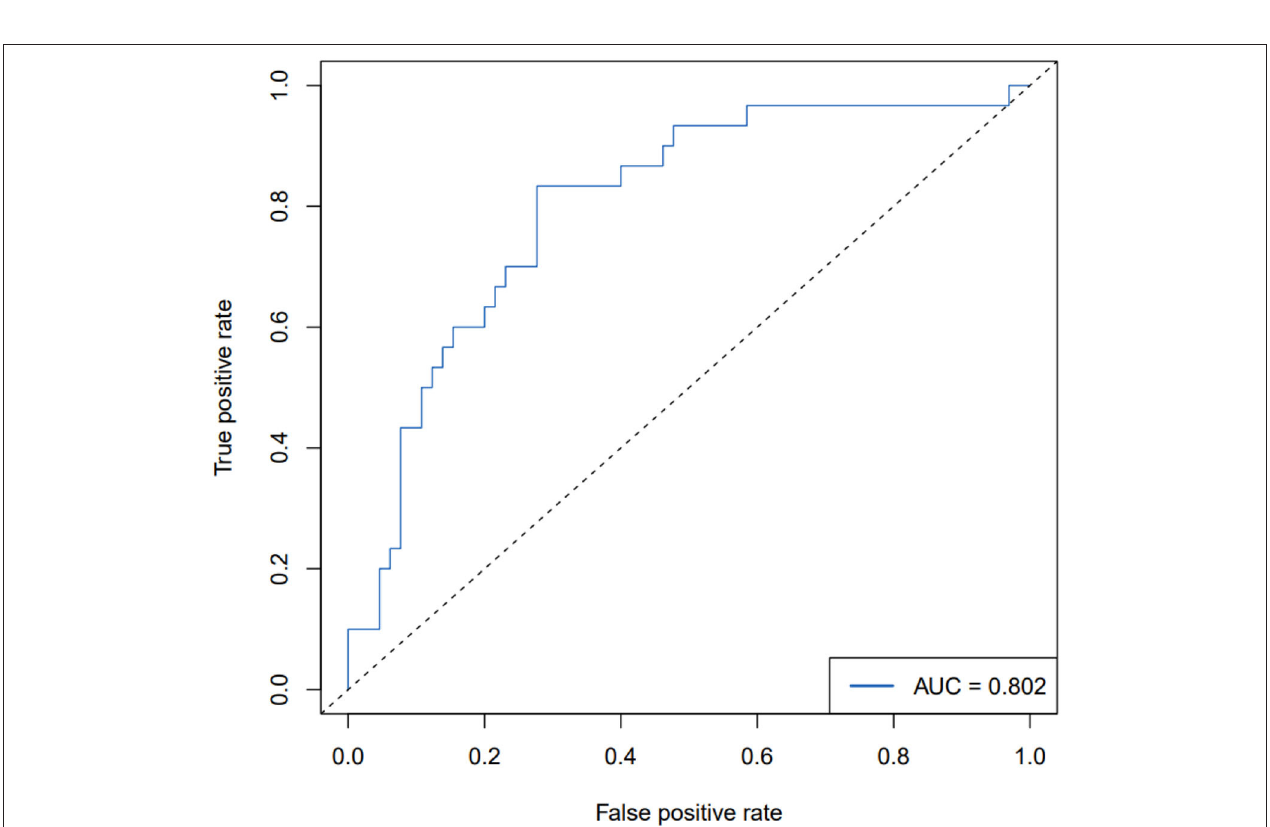
FIGURE 3 | ROC curve for the backward stepwise regression method combined with the AIC model for predicting PEF impairment in patients with ALS in the test set.